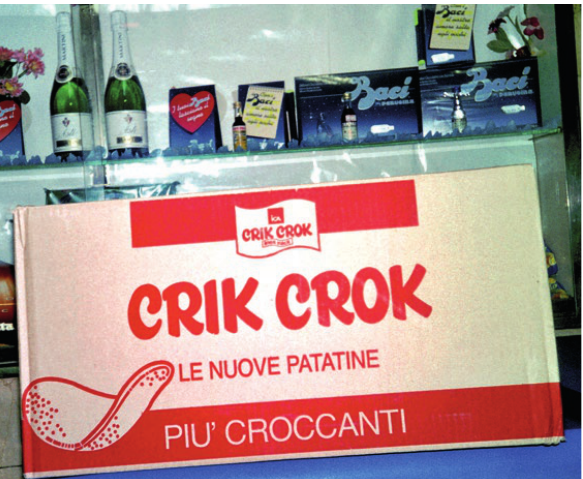
Figure 28. Roman signwriter’s view of an unlikely elliptic potato crisp, whose boundary is hyperbolic (cf. Fig.